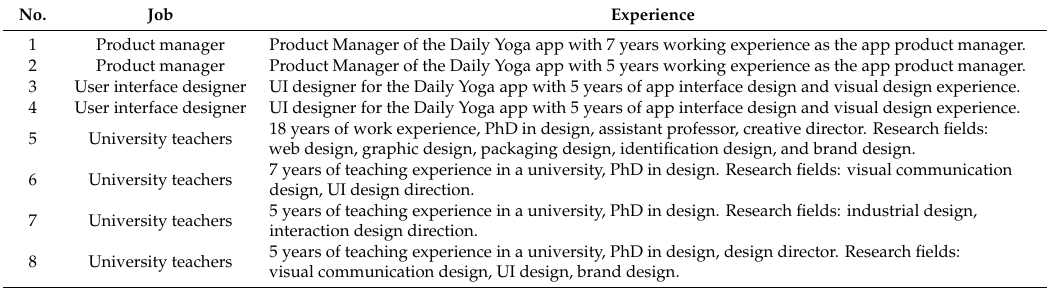
Table 1. Backgrounds of Delphi